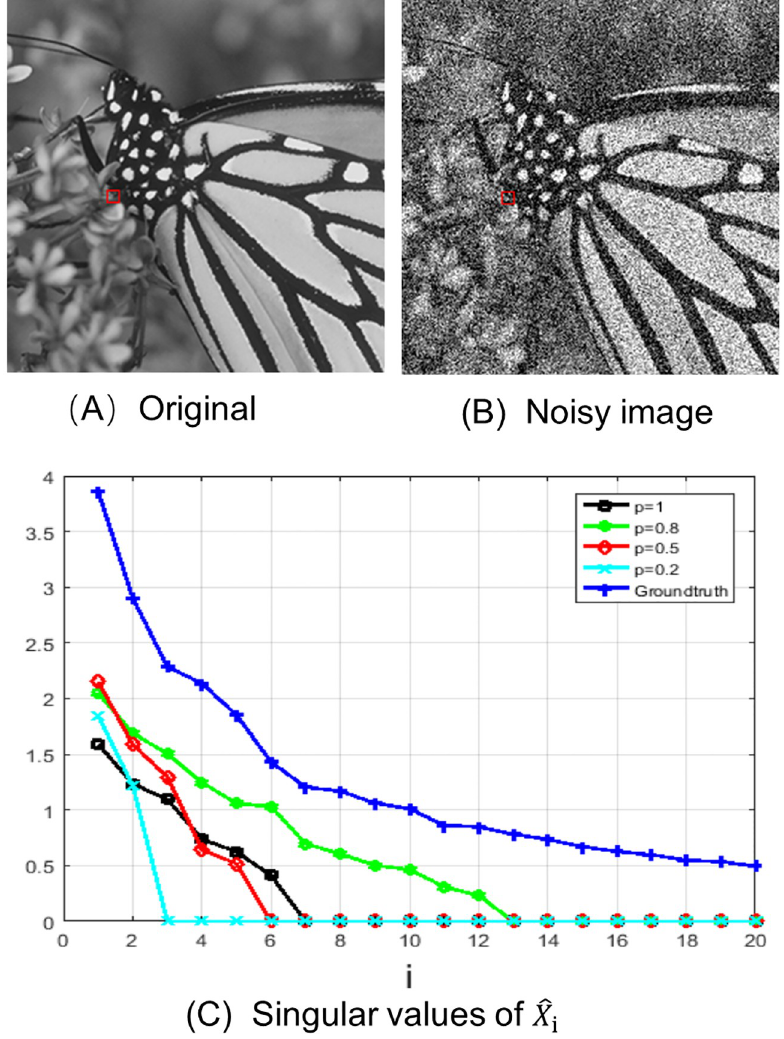
Fig 2. Illustration of the over-shrinkage problem with the value of power p . (A) Original image. (B) Noisy image with σ n = 50. (C) Singular values of ^ X i